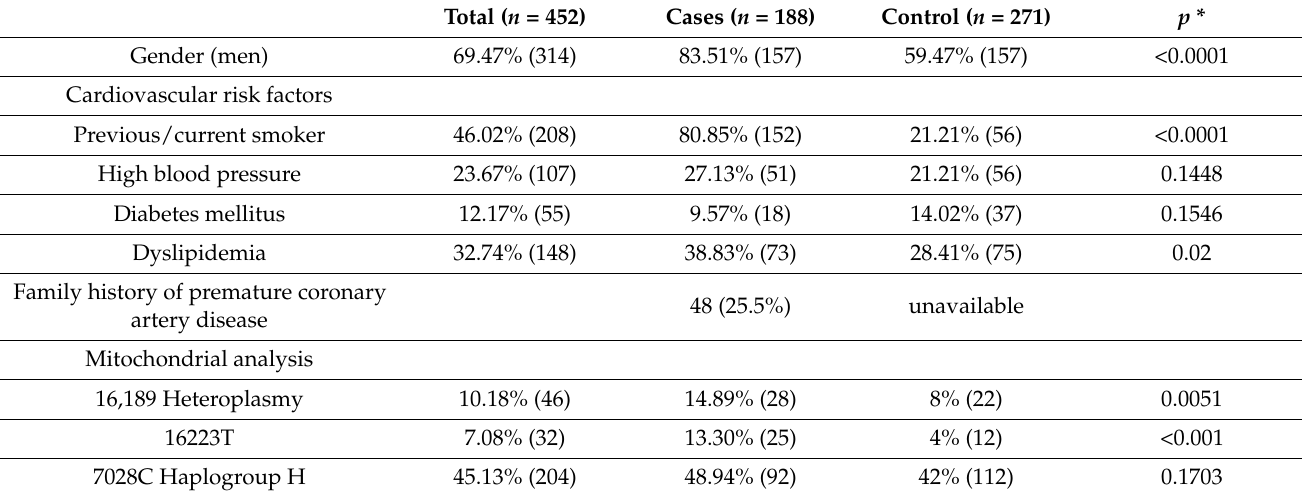
Table 1. Clinical and mitochondrial characteristics of patients presenting with premature ST-elevation myocardial infarction (premature STEMI = cases) and control